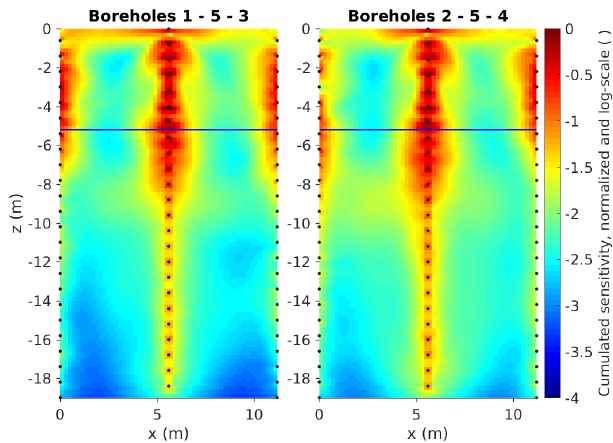
Figure 5. Cumulated sensitivity distribution for the inverted back- ground ( T 0) dataset for both